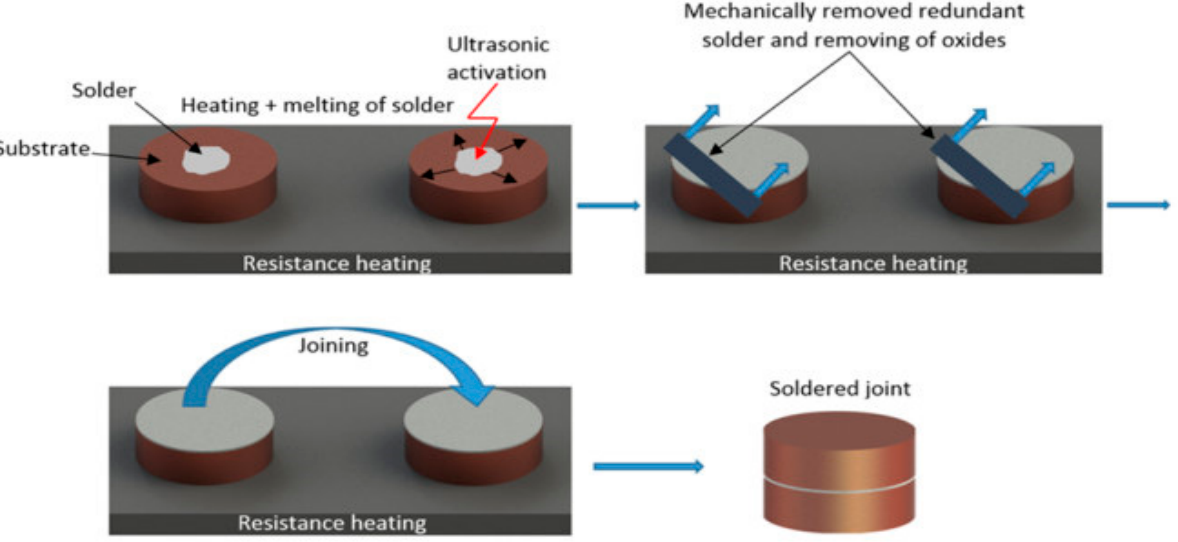
Figure 4. Schematic representation of ultrasonic soldering. Table 2. Soldering parameters.